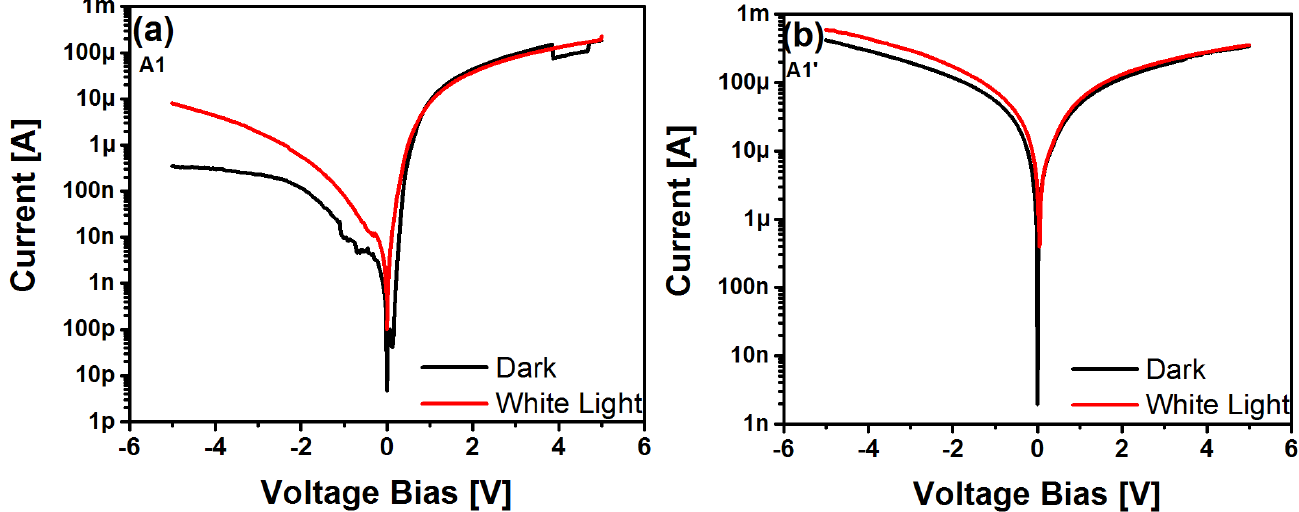
Figure 8. I-V curves of MIS-like structures with SRO films without ( a ) and with ( b ) annealing at the dark and white light illumination states .